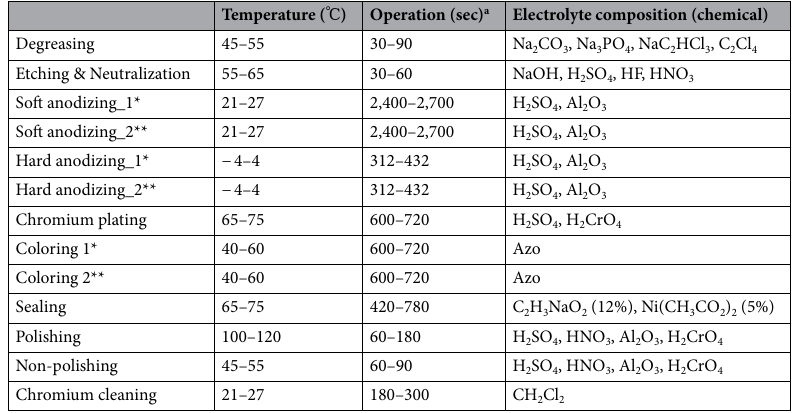
Table 1. Temperature, operation time and used chemical in all the processes. *1 = Medium size of bath. **2 = Large size of bath. a Time(second) to make 1